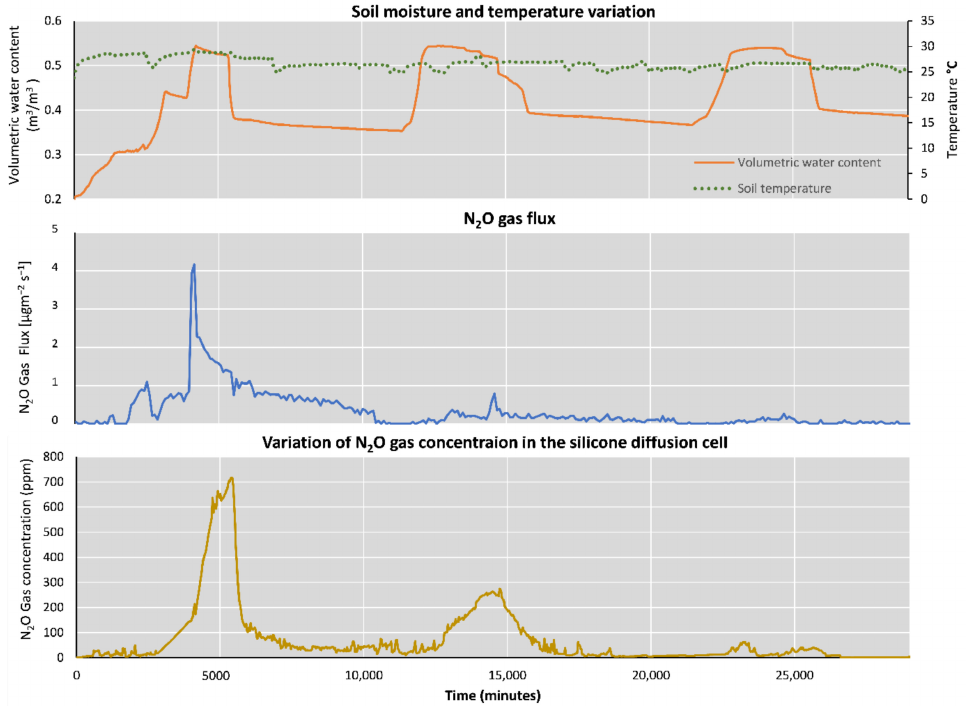
Figure 7. Temporal variations in the N 2 O gas concentrations in the silicone diffusion cell and N 2 O gas flux from the headspace, soil temperature, and moisture levels in experiment